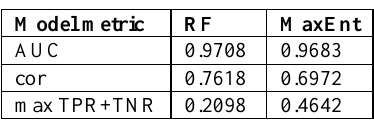
Table 3 . SDM metrics for RF and